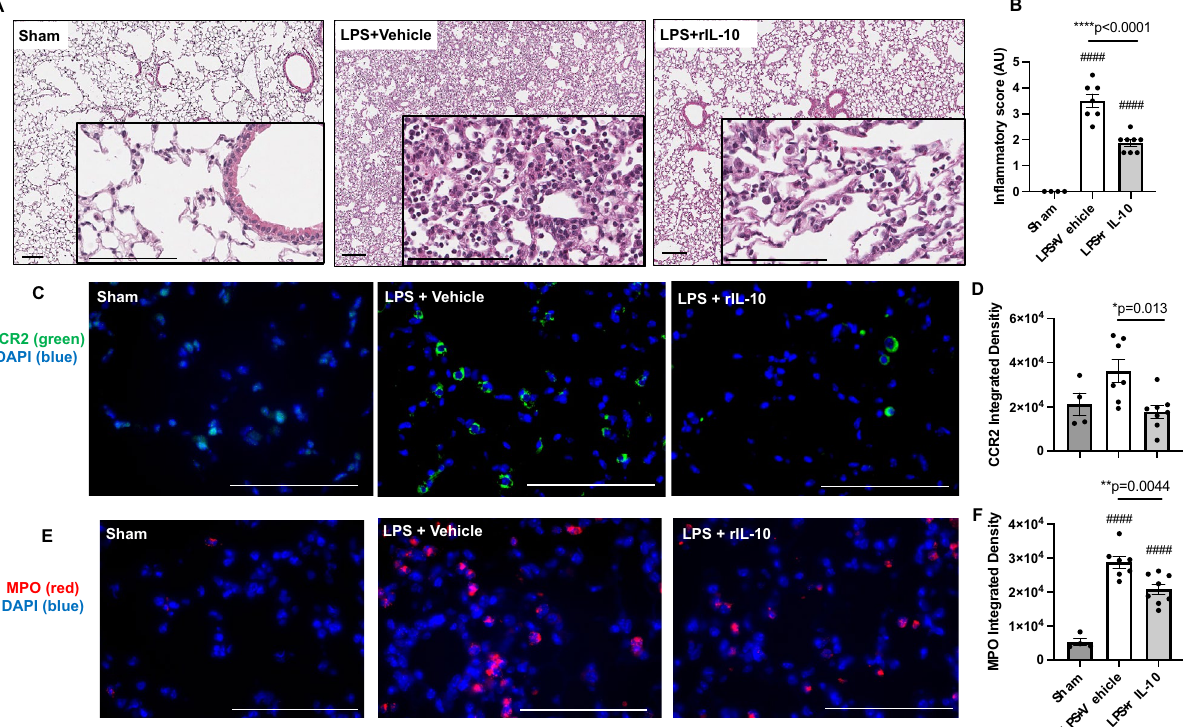
Figure 6. Treatment with rIL-10 reduces lung inflammation, CCR2 + inflammatory monocytes, and MPO + neutrophils following a one-time high dose LPS exposure. Representative H&E-stained lung section images from both treatment groups and sham (saline control) ( A ) with semi-quantitative lung inflammatory score ( B ) shown. Confocal images of lung tissues stained for CCR2 + inflammatory monocytes/macrophages (green) ( C ) and myeloperoxidase (MPO) + neutrophils (red) ( E ) with nuclei staining by DAPI (blue) and integrated density of CCR2 ( D ) and MPO ( F ) quantified per each mouse. Individual values are averaged from 8 to 10 images per section per mouse. Statistical significance vs. sham (####p < 0.0001). Asterisks (*p < 0.05, **p < 0.01, ***p < 0.001). Line scale is 100